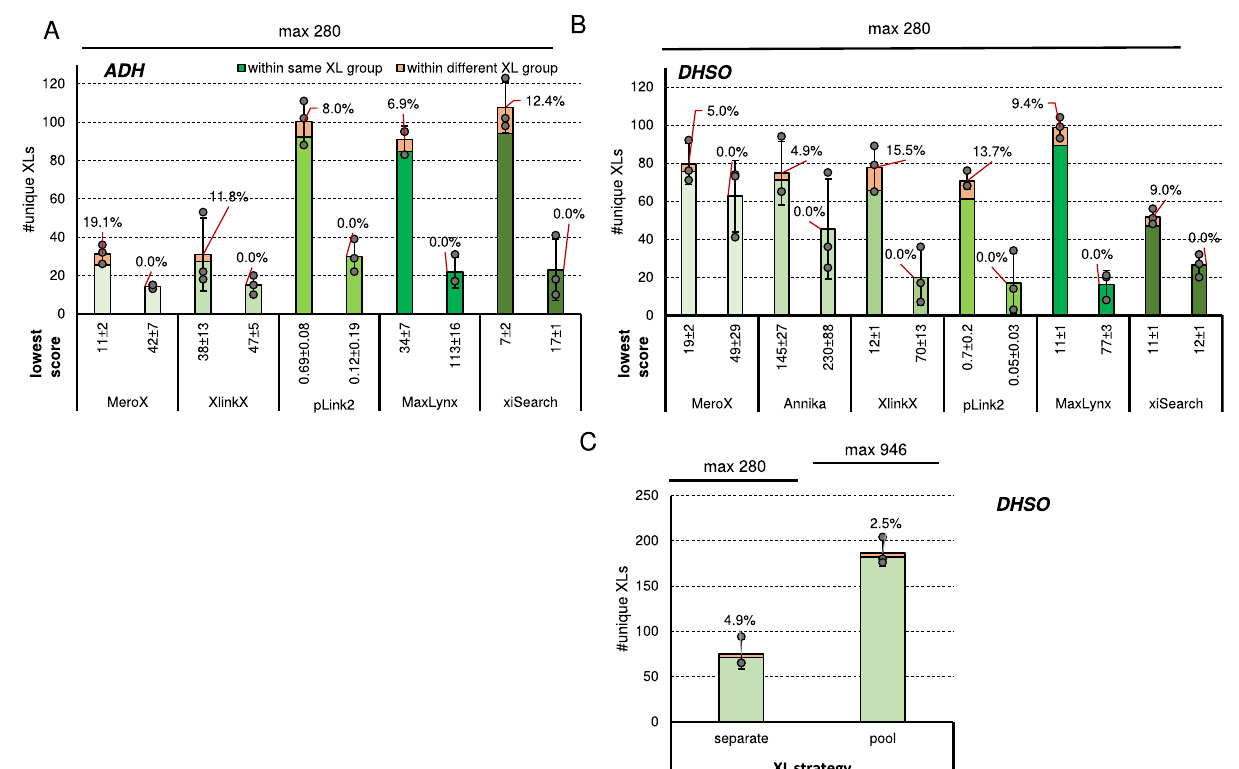
Fig. 4 Benchmarking linker reagents reactive to acidic amino acids. Average number of unique link IDs and maximal theoretical number of true crosslink combinations after acquisition using a stepped HCD MS2 strategy when using ADH ( A ) or DHSO ( B ) to crosslink the acidic library. Data analysis was performed using the indicated algorithm at 1% estimated FDR (solid line bars) and corrected by applying a post-score cutoff to reach an experimentally validated FDR < = 1 (dashed line bars). C As B but when crosslinking the library either in separate groups or adding the linker to a pool of all peptides to boost resulting ID numbers. Data analysis using MS Annika at 1% estimated FDR. A – C The experimentally validated FDR is shown as callout, error-bars indicate standard deviations of average values, n = 3 independent samples acquired on different days. Source data are provided as a Source Data fi